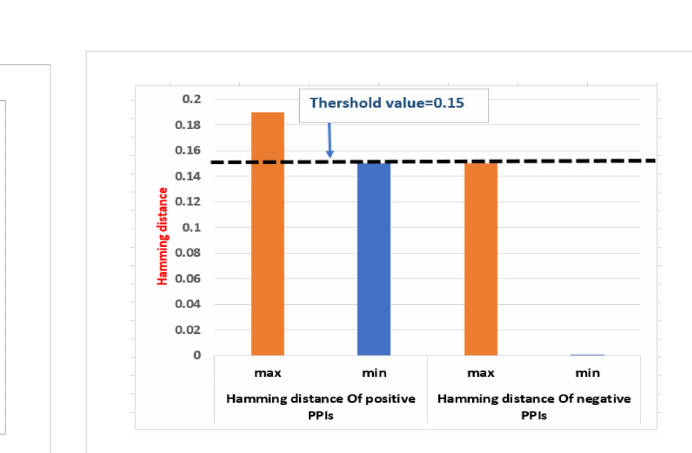
FIGURE 5 Threshold value calculation from positive PPIs and negative PPIs.